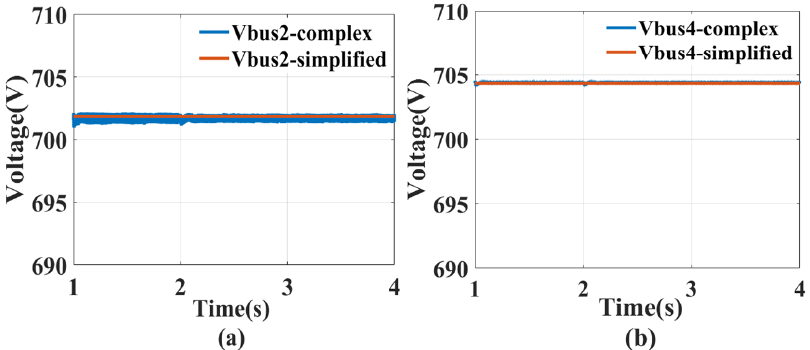
Figure 6. The bus voltage comparison for Bus 2 and Bus 4, which are connected to PV systems: ( a ) the comparison for Bus 2 and ( b ) the comparison for Bus 4.